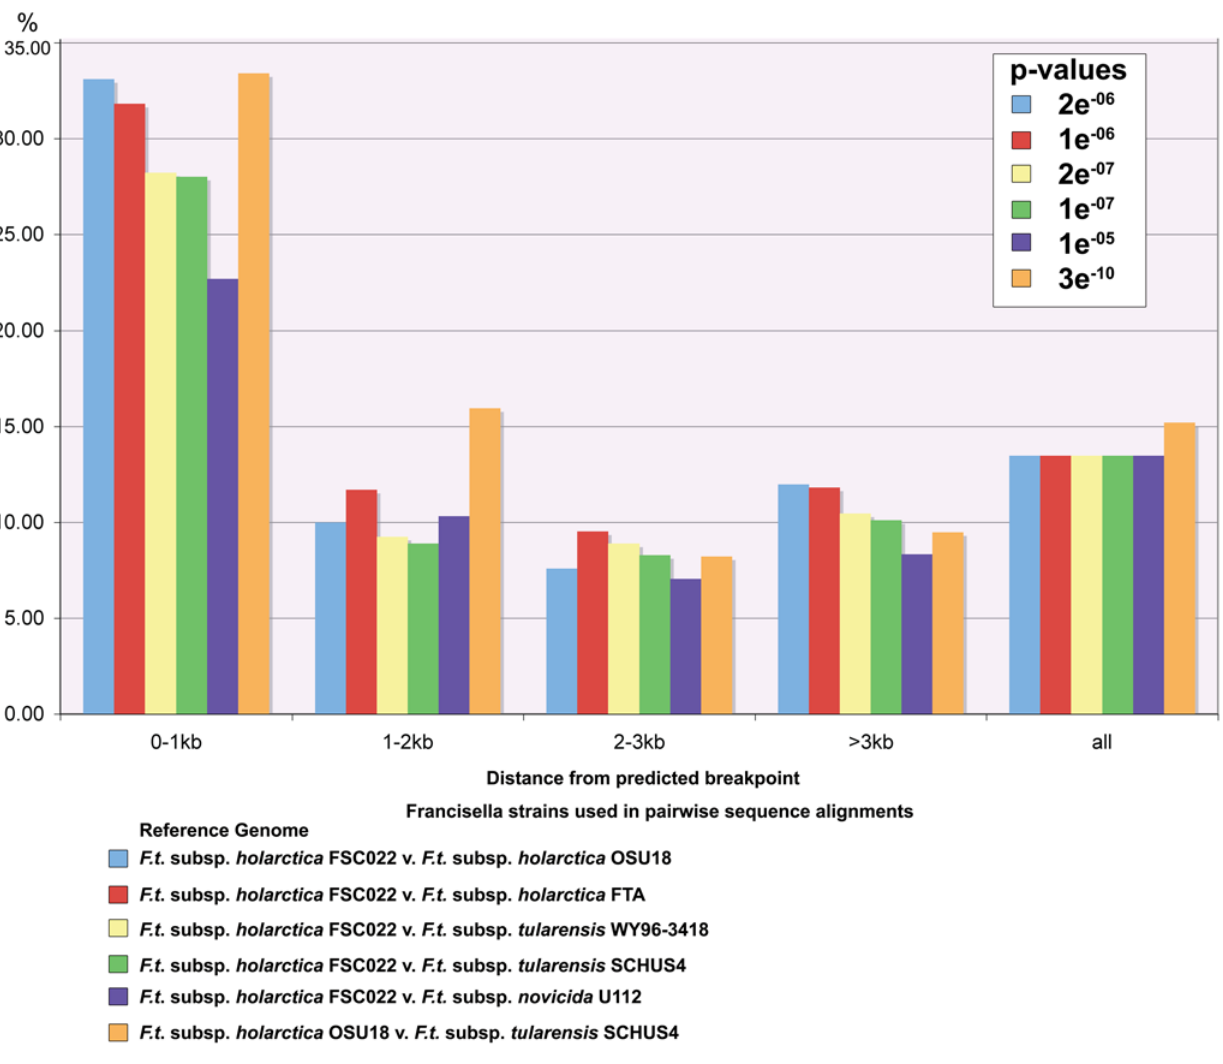
Figure 5. Comparisons of pairwise sequence alignments provides evidence of pseudogene enrichment within 1 kb of predicted breakpoints in Type B strains. Pairwise sequence alignments using F. tularensis subsp. holarctica (Type B) strains as a reference were further analyzed for evidence of gene decay proximal to predicted breakpoint sites. Total ORF counts were used to determine the percentage of pseudogenes (y-axis) relative to the distance from the predicted breakpoint (x-axis). Pseudogene enrichment was determined using Fisher’s Exact Test to derive p-values. Our findings show the highest percentages of pseudogenes are found within 1 kb of the predicted breakpoints indicating that genome rearrangement events have likely promoted gene decay in strains of the Type B